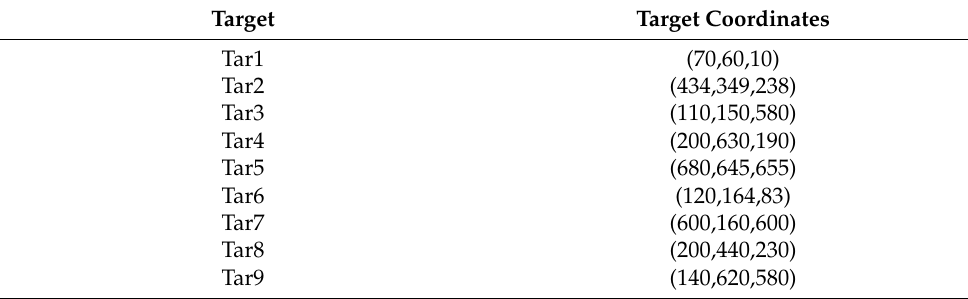
Table 4. Target point